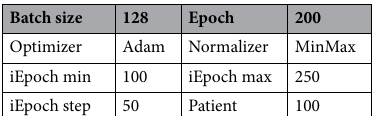
Table 2. The hyper-parameters of the ensemble learning-based prediction model.